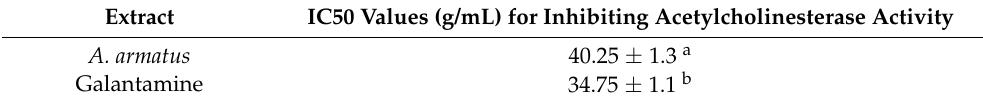
Table 3. Galantamine standard and A. armatus fraction IC 50 values (g/mL) for inhibiting acetyl- cholinesterase